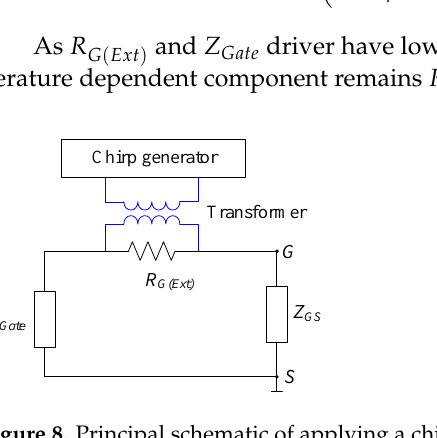
( a ) ( b ) Figure 9. Schematic ( a ) without gate driver; ( b ) with gate driver. In the experiment, the transformer was attached to the gate resistor that forms part of the Wolfram/Cree SiC MOSFET second generation (C2MTM) gate driver board. This gate driver board is a pull–push voltage gate driver. The high level is set to 20 V and the low level is set to −5 V. Both voltages are isolated due to two onboard isolated DC/DC converters RP1212D and RP1205S. The pulse width modulated signal (PWM) passes through the LED driver ACPL4800300E, which connects with the output gate driver IXDN609SI. During the off-state of the SiC MOSFET, the output impedance 𝑍 𝐺𝑎𝑡𝑒 of IXDN609SI becomes resistive as the MOSFET driver of IXDN609SI is in its on-state to pull the gate to −5 V. The datasheet shows that the low state output resistance is 400 mΩ and shows low temperature dependency [33]. As the MOSFET driver is in its on-state, an on- state voltage of approximately 1 V applies. The RF transformer chosen is the Coilcraft RF transformer (part number: PWB1010L) with a bandwidth from 0.0035 MHz to 125 MHz . The impedance ratio of the primary winding against the secondary winding is 1:1 (750 µH primary/750 µH secondary). The attenuation of the transformer between 0.02 MHz to 30 MHz is approximately 0 dB, (i.e., gain of 1) [34]. According to the data sheet provided by the manufacturer, the phase and magnitude imbalances in the same frequency range are extremely close to 0 dB [35]. The RF transformer also offers isolation between the chirp generator and the gate signal. 5.2. Online Estimation The Cree/Wolfspeed SiC MOSFET and the C2MTM modified Cree gate driver board are embedded in the Cree/Wolfspeed 8020-CRD-8FF1217P-1 boost DC/DC converter eval- uation board [33]. Figure 10 shows the schematic of the boost converter and Figure 11 shows the experimental setup.